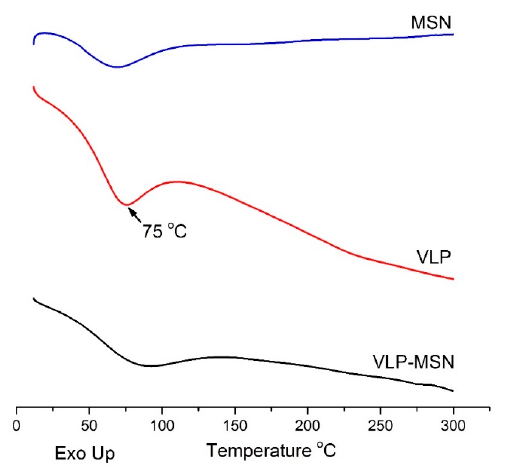
Figure 6. DSC thermograms of MSN, VLP, and VLP-MSN.